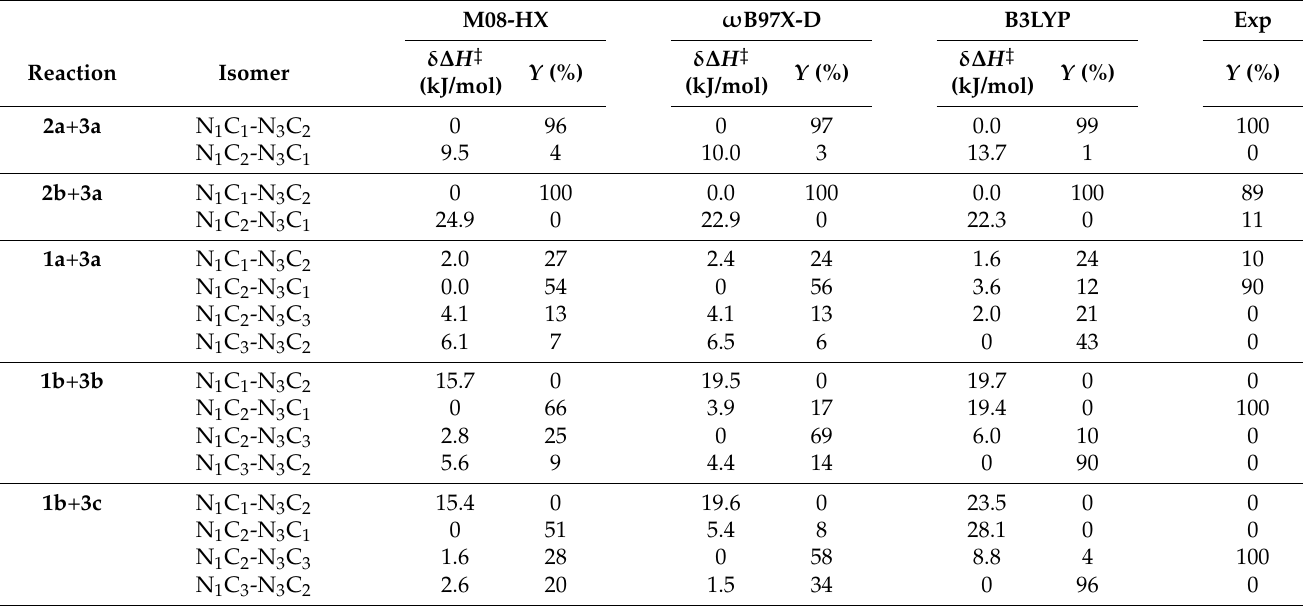
Table 7. Enthalpy difference between isomeric TSs ( δ ∆ H ‡ ) and corresponding isomeric ratio ( Y ), calculated using the M08-HX, ω B97X-D, and B3LYP functionals and compared to the experimental isomeric ratio. M08-HX ω B97X-D B3LYP